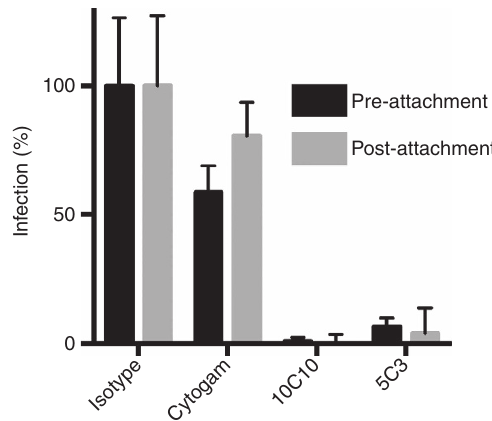
Figure 6 | The anti-gH mAbs 10C10 and 5C3 neutralize infection at a post-attachment step. AD169 IE2-YFP was incubated with MRC5 cells at 4 (cid:2) C followed by addition of Cytogam, an isotype control or anti-gH mAbs 10C10 and 5C3. Following an additional incubation at 4 (cid:2) C, cell/virus/antibody were transferred to 37 (cid:2) C. Infection levels (grey bars) were measured at 16 hpi and compared with virus prep that had been pre-incubated with mAbs before exposure to cells (black bars). Experiment was performed in technical triplicate and was replicated four times. S.d. is depicted for all experiments.